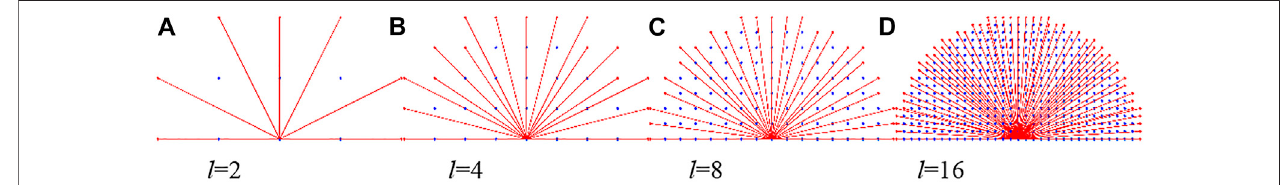
FIGURE 2 | Relationship between segment length l and angle resolution.